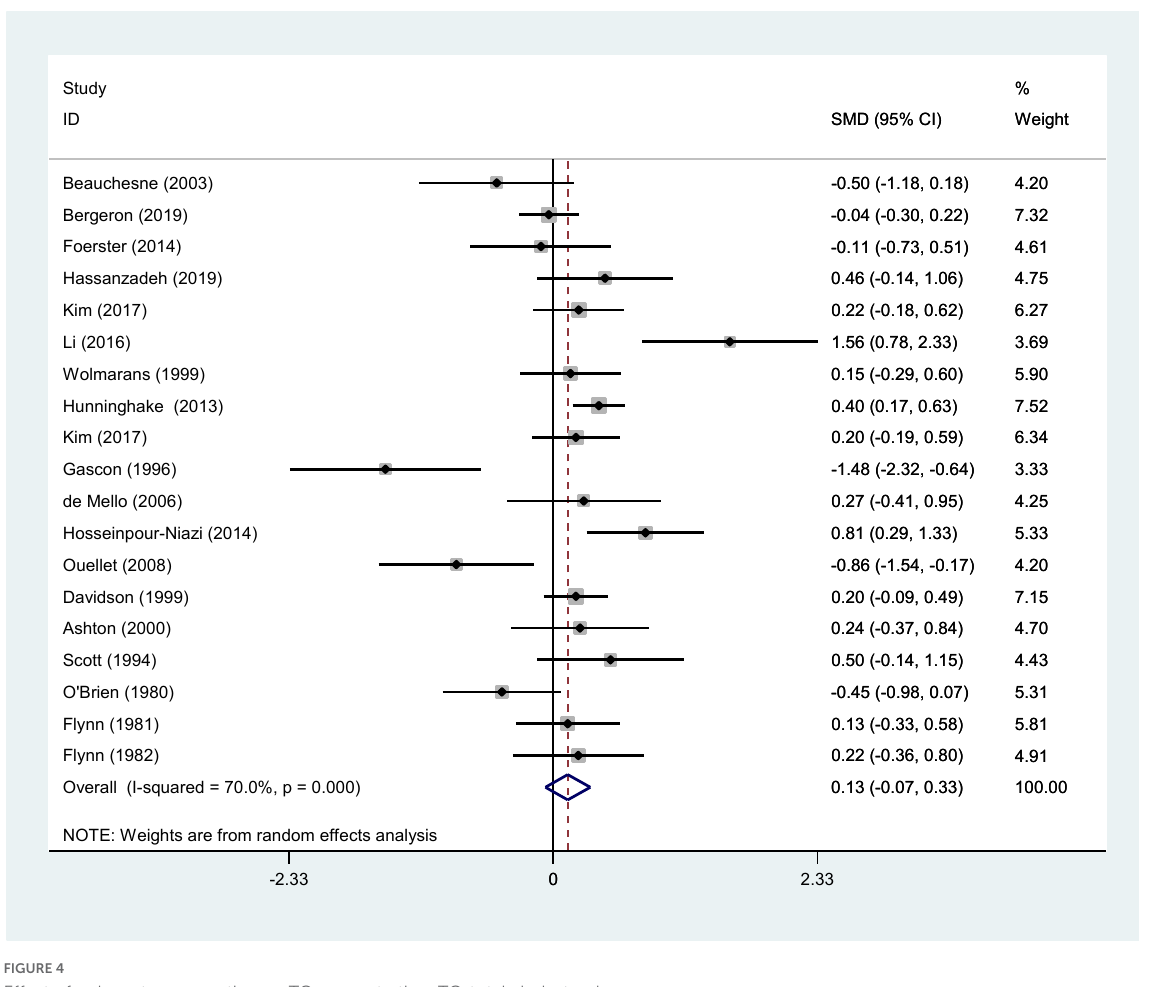
FIGURE4 Effect of red meat consumption on TC concentration. TC, total cholesterol.